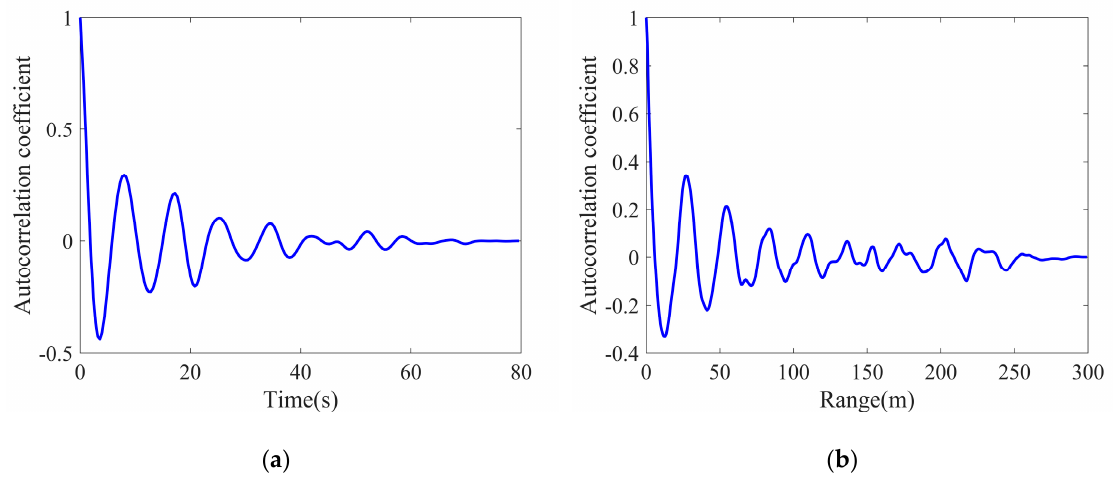
Figure 5. Average correlation coefficients of real texture: ( a ) Temporal correlation; ( b ) Spatial correlation.